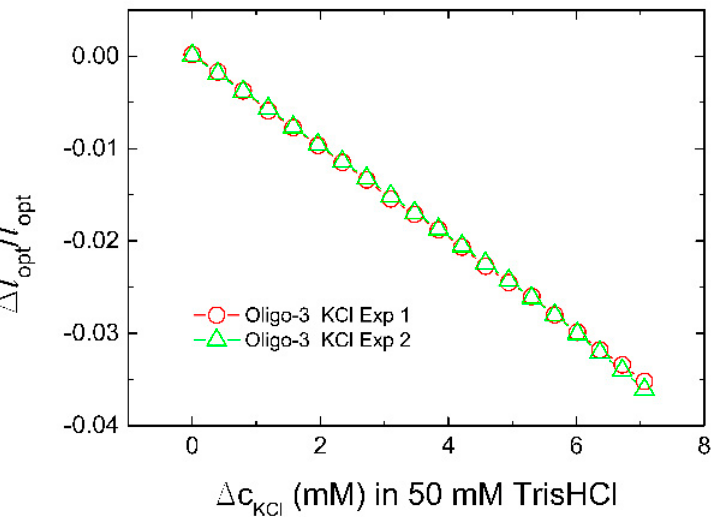
tion of KCl added to 50 mM Tris buffer (pH 7.4) for oligo-3-co-AAm hydrogel sensing element at the end of an optical fiber. The hydrogel sensor was extensively washed in 50 mM Tris buffer (pH 7.4) following completion of the first experimental series (Exp 1) to re-equilibrate the hydrogel, followed by step-wise increase of KCl in the second experimental series (Exp 2).